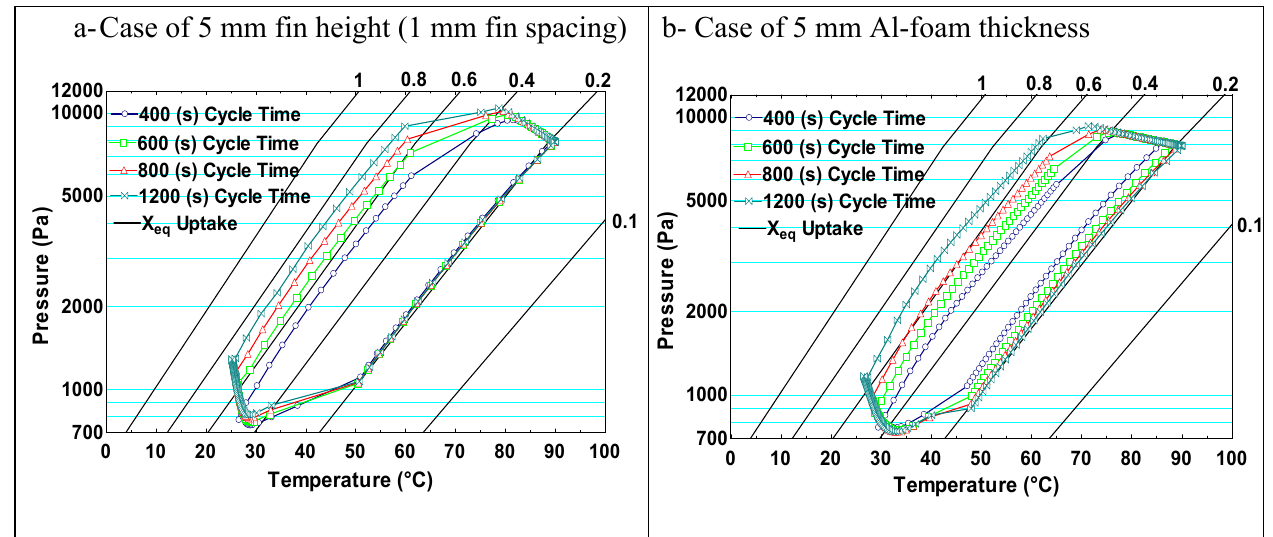
Figure 7. The T-P-X diagram for the bed of both systems during the cyclic steady state at different cycle times and 5 mm fin height/foam thickness. ( a ) Finned-tube based bed, ( b ) Al-foam based bed. At a cycle time of 400 s, the effective uptake in the foamed bed was much lower than that attained by the finned-tube bed, as can be shown by comparing Figure 7a,b, for 5 mm fin height/foam thickness. Increasing the cycle time enhanced considerably both beds’ uptake at the end of the adsorption process. In the foamed bed, the lower limit of the uptake at the end of the desorption process decreased with increasing the cycle time and reached about 0.2 kg/kg at a cycle time of 1200 s. This affected positively the performance of the Al-foam based system for the higher cycle time. The net effects of changing the cycle time on the percentage change in the COP and DIP of the adsorption system when fixing the fin height/foam thickness at 5 mm are shown in Figure 8. The COPs of the Al-foam based system outperformed those of the finned-tube based system with 1 mm fin spacing at all cycle times. The maximum increase of the COP was 26.7% at 1200 s. However, using the foamed beds to enhance the COP compared to the finned-tube based system with 2 mm fin spacing can only be achieved at higher cycle times of 800 s (2.3% increase) and 1200 s (6.8% increase), as shown in Figure 8a. Working at higher cycle times of 800 s and 1200 s can also enhance the DIPs of the Al-foam based system over those of the finned-tube based system with both 1- and 2-mm fin spacings. The maximum increase of only 16.8% (which was 39.3% at 2 mm foam thickness, Figure 6b in the DIP of the Al-foam based system was attained at a cycle time of 1200 s 0.4 and 5 mm foam thickness, as shown in Figure 8b. This was due to the negative effect of using less adsorbent mass in the foamed beds compared to the finned-tube beds, which was not compensated by higher heat and mass transfer enhancement as in the case of 2 mm foam thickness. Additionally, the performance of the Al-foam based system was affected more negatively by the reduction of the total number of tubes used in each bed (the total number was reduced from 309 to 95 tubes). The reduction in the number of tubes leads to a reduction in cooling and heating mass flow rates in the case of 5 mm foam thickness. Using a foam thickness of 5 mm was better in terms of the system COP compared to 2 mm foam thickness at each cycle time. The maximum COP of 0.366 for the Al-foam based system was attained at a cycle time of 1200 s, as shown in Figure 8. On the other hand, the DIP was reduced by 20.1% (from 99.1 to 79.1 kg ice · day − 1 ) when changing the cycle time from 400 s to 1200 s, compared to a 47.5% reduction (from 186.2 to 97.6 kg ice · day − 1 ) in the same case with 2 mm foam